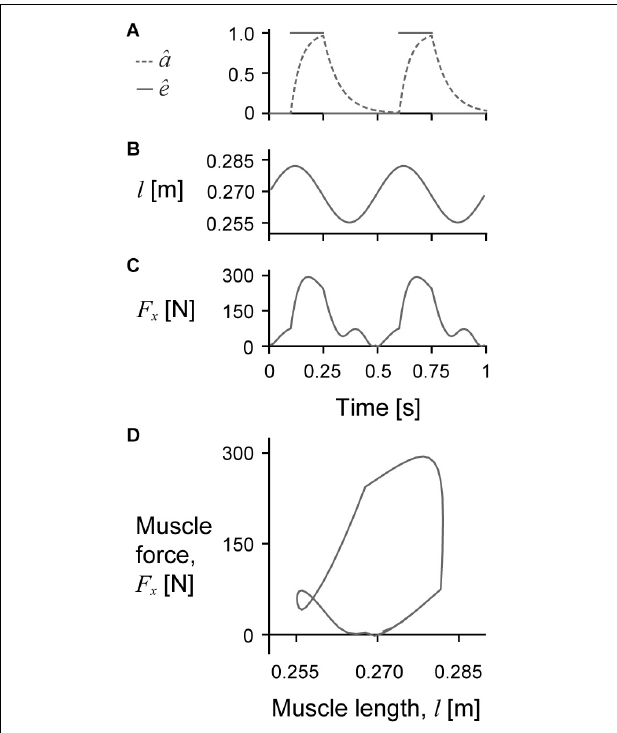
FIGURE 2 | Sample raw simulation traces. Raw traces of normalised excitation ê (solid lines) and activation â (dashed line) over time (A) , muscle length l over time (B) , muscle force F x over time (C) , and F x over l in which the area inside the loop represents the mechanical work per cycle (D) for a representative simulation with a cycle strain amplitude of 5%, maximum normalised excitation of 1, initial pennation β 0 of 15.3 ◦ , and scale of